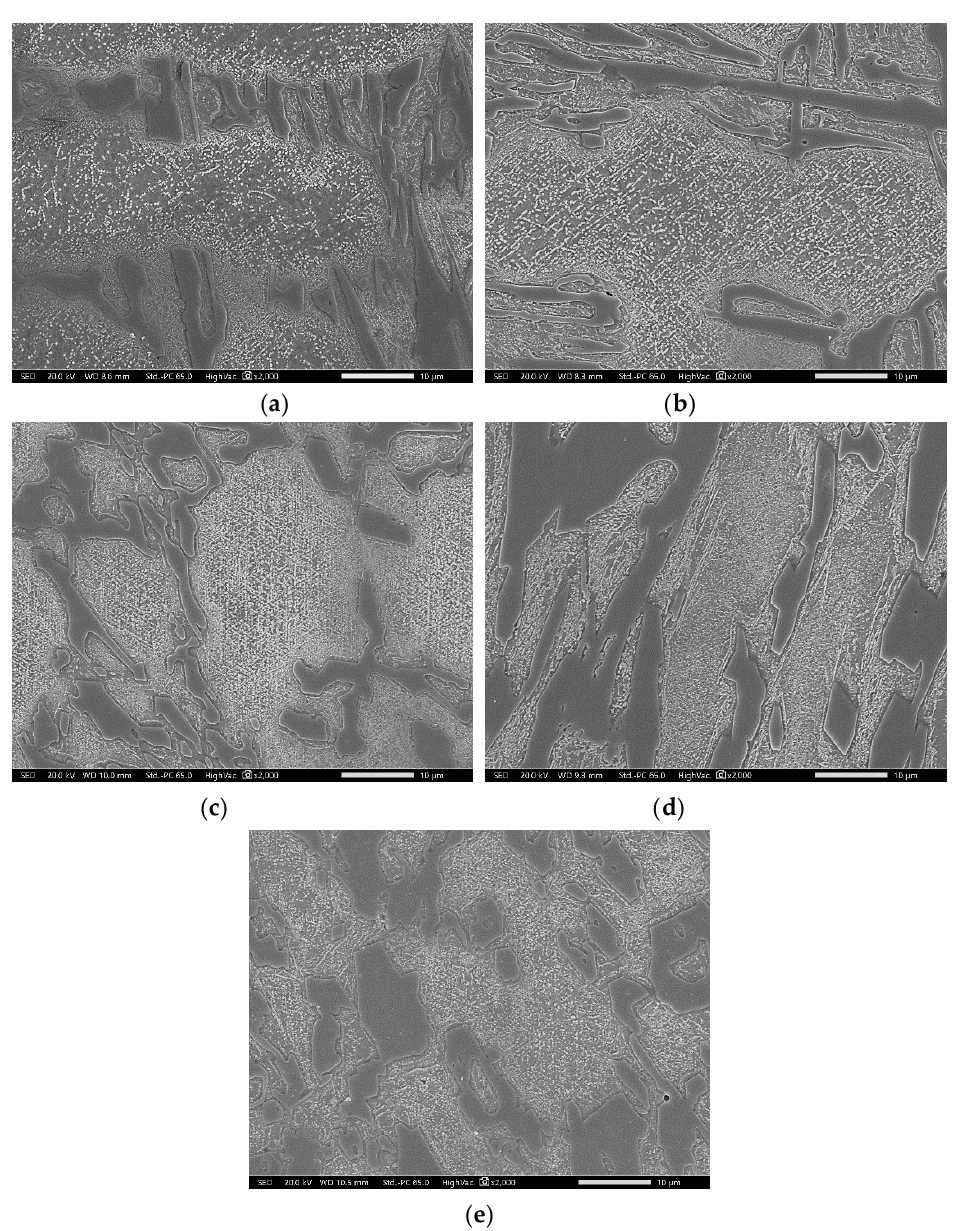
Figure 10. Micrographs of DA-treated alloys: ( a ) 2124; ( b )2127; ( c ) 2427; ( d ) 2827; ( e ) 2927.